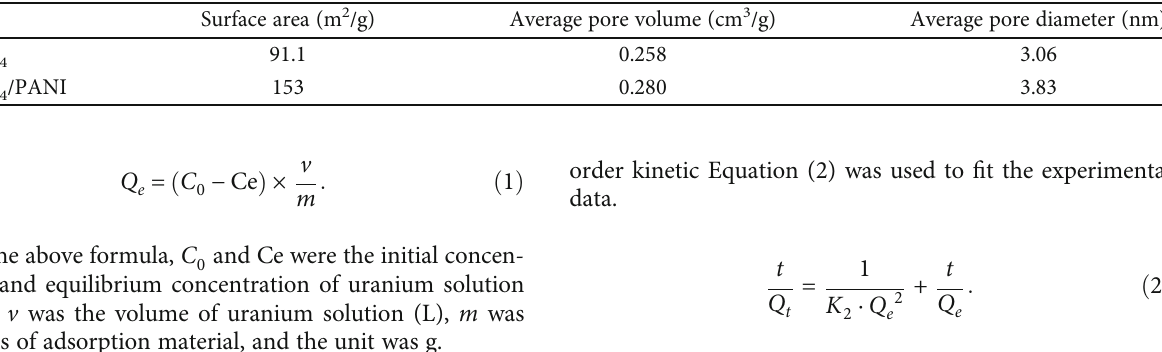
O nanoparticles and CuFe 2 4